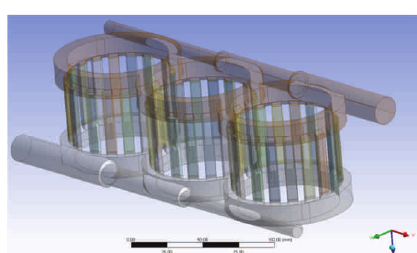
Fig. 8. Model with variable geometry of the intake and exhaust channels